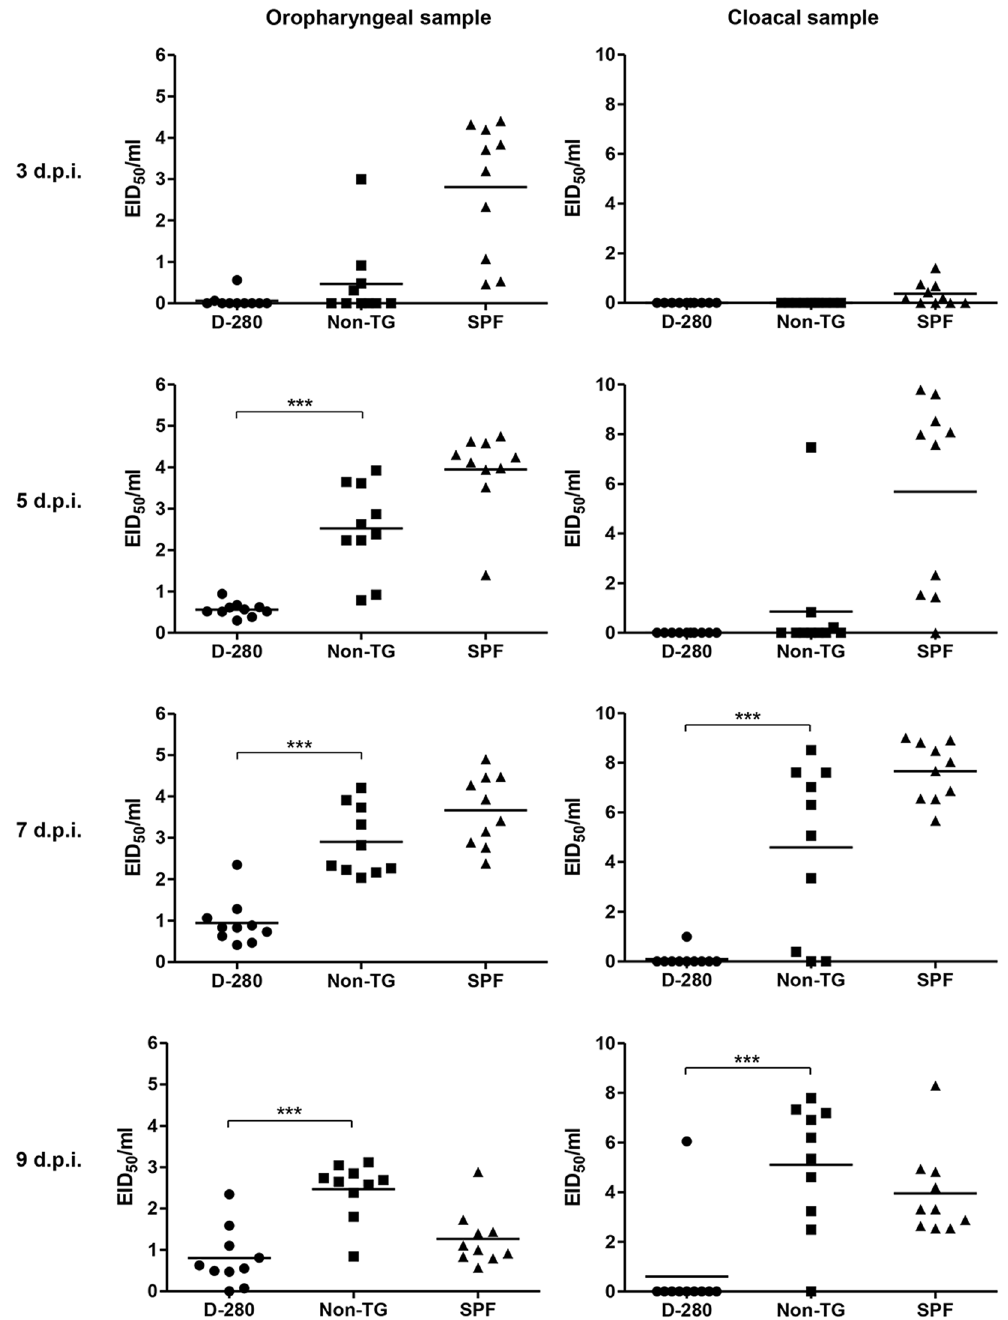
Figure 7. Viral shedding of contact exposed transgenic chickens. Twenty three-week-old non-transgenic chickens (non-TG) and transgenic chickens (D-280) were housed each containment cages in a BSL2 animal facility, and an additional twenty three-week-old SPF chickens were housed as a control group. Ten chickens from each group were intranasally challenged with 100 μ l of 10 7.5 EID 50 /mL H9N2 virus. The other 10 naïve chickens in each group were co-housed in the same containment isolator from 6 hour post-inoculation. Oropharyngeal and cloacal swab samples were collected at 3, 5, 7, and 9 days post-inoculation (dpi) from contact exposed chickens and the viral RNA was quantified by real-time RT-PCR. Each cycle threshold value was extrapolated to egg infectious dose fifty and mean viral shedding titers were calculated. *** p < 0.001 by unpaired t